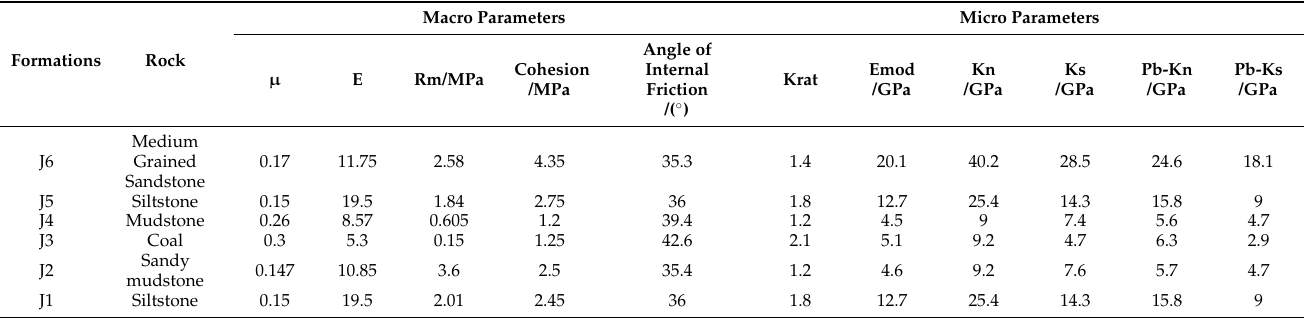
Table 2. Macroscopic and mesoscopic physical and mechanical properties of rock formations (access to